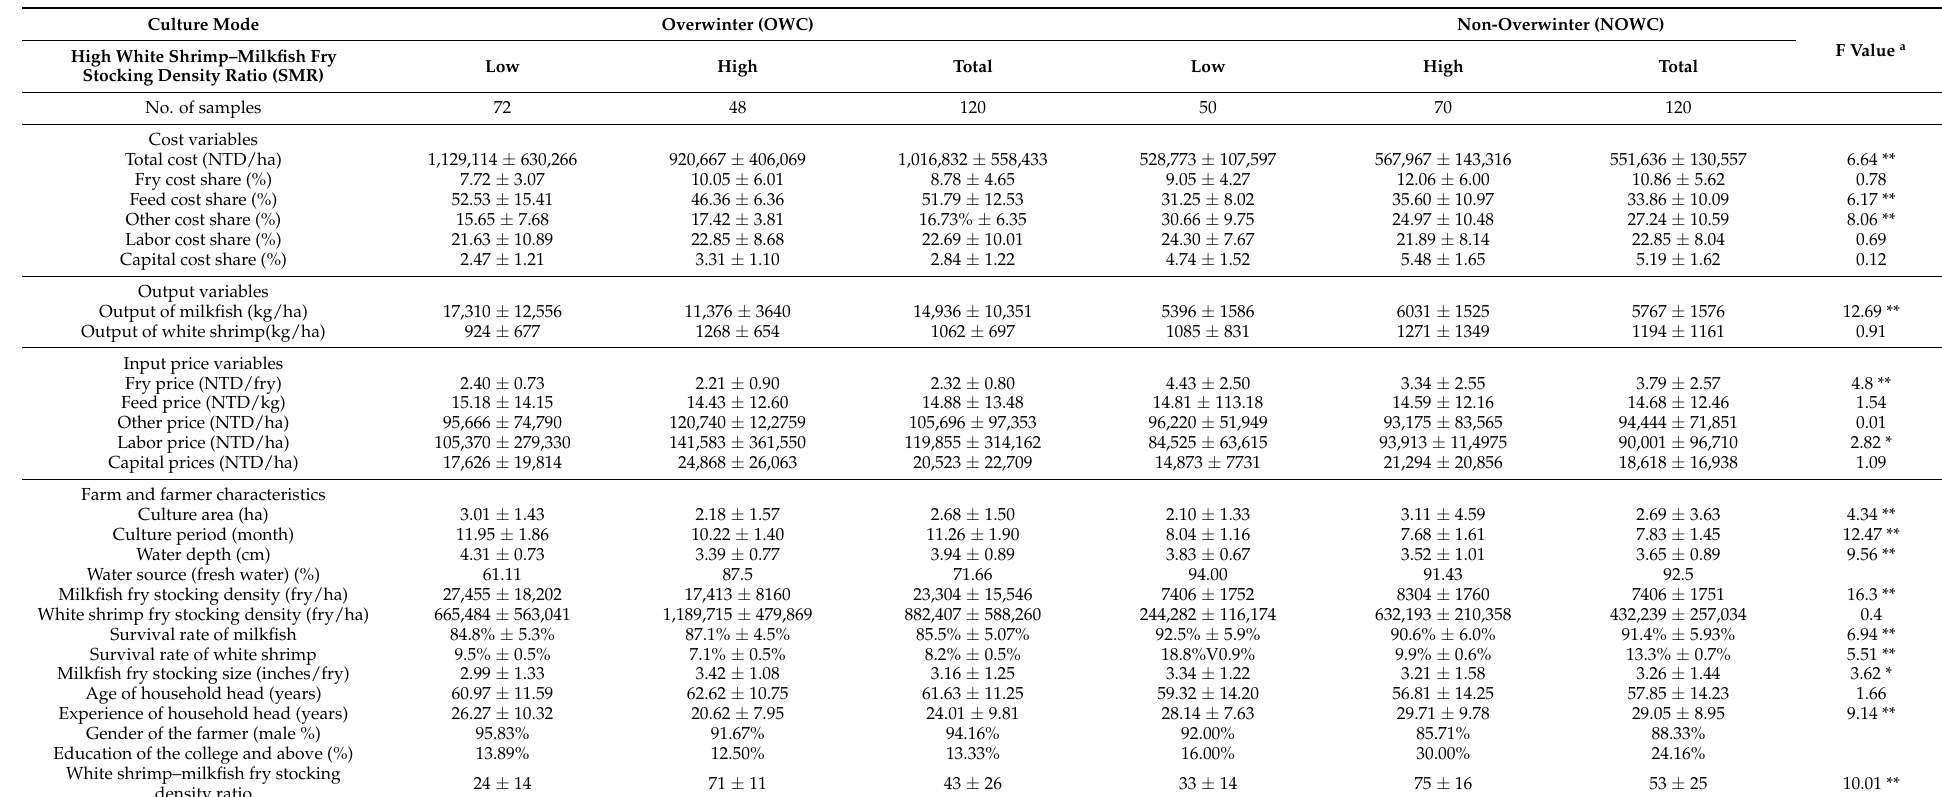
Table 2. Descriptive data of the observed farming household